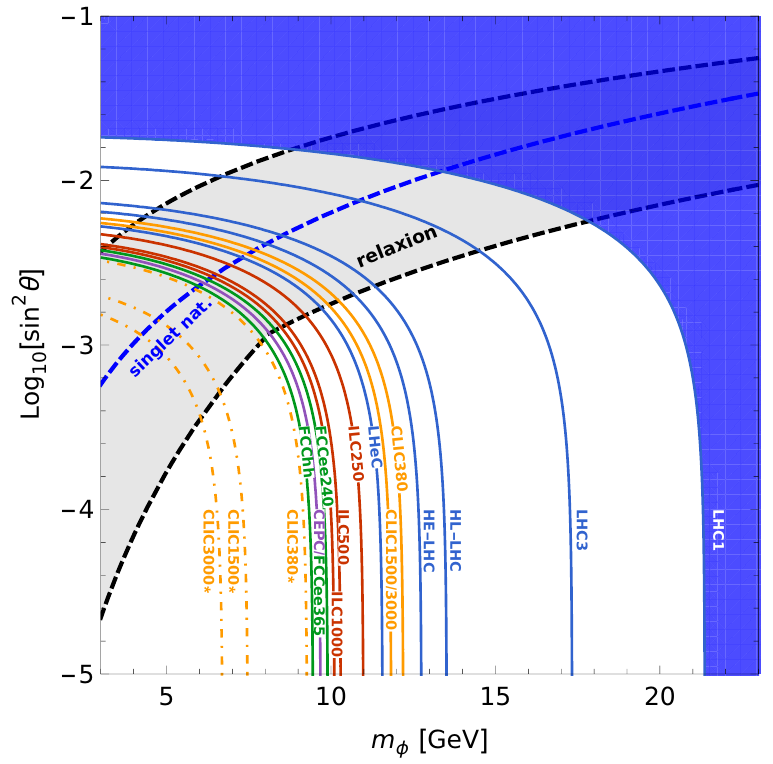
Figure 3 . Existing and projected constraints on sin 2 θ and m φ from bounds on the branching ratio of Higgs to untagged or BSM final states listed in table 1. The blue shaded area is already excluded. The limits from FCCee at 365 GeV and CEPC coincide (purple). CLIC at 3 TeV does not improve the CLIC limit at 1 . 5 TeV (solid yellow). The dash-dotted bounds for CLIC labelled by a * indicate the sensitivity from the 1-parameter fit to BR dashed dark blue line represents the upper naturalness bound sin θ ≤ m eq. (2.19). The gray band within the black dashed lines is the natural relaxion range defined by eqs. (2.38), (2.39) and